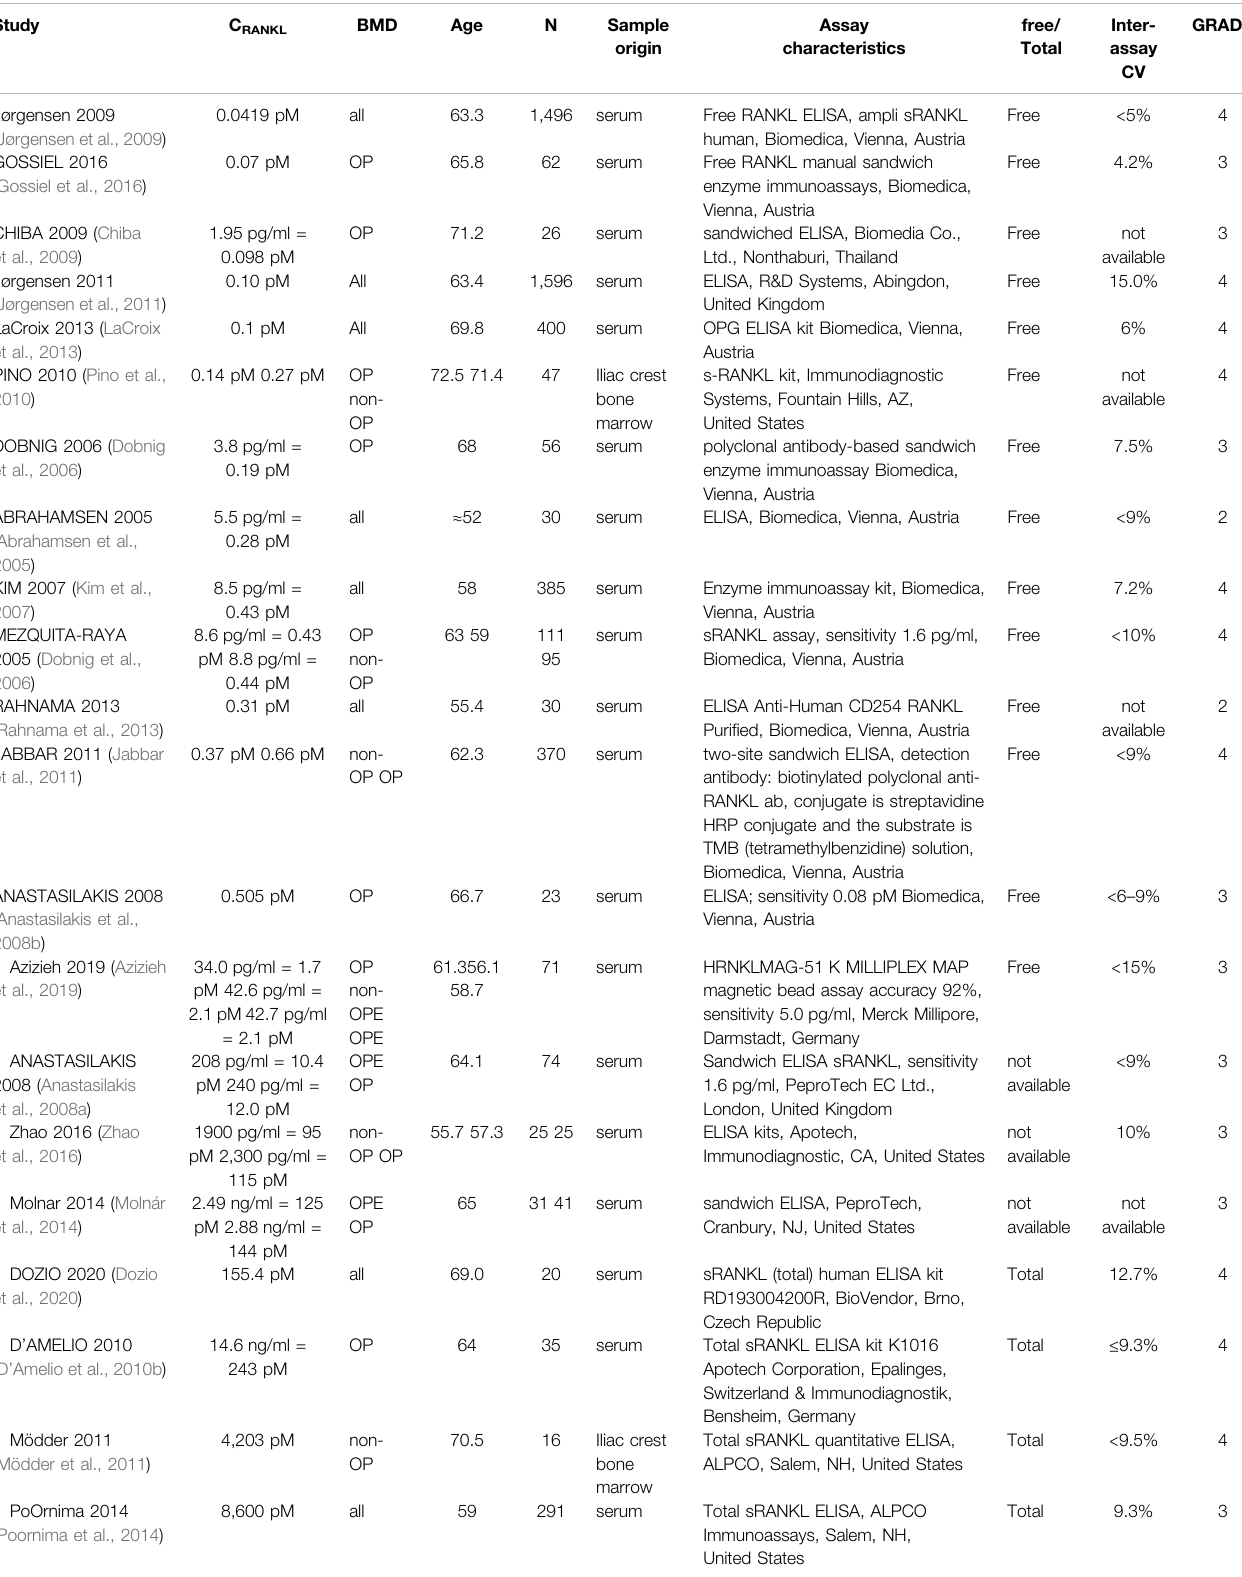
TABLE 4 | RANKL concentration measurements in postmenopausal women, in ascending order. Study